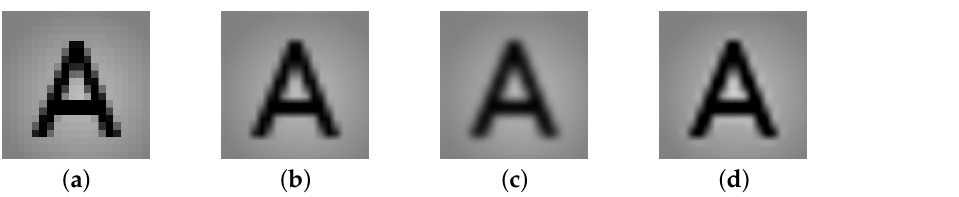
Figure 5. The model of the quality assessment submodule.